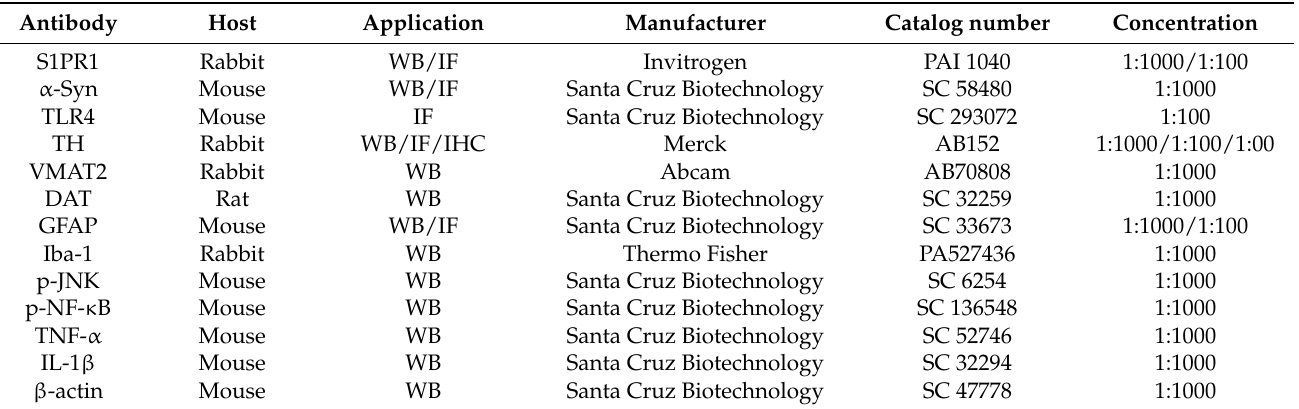
Table 1. List of